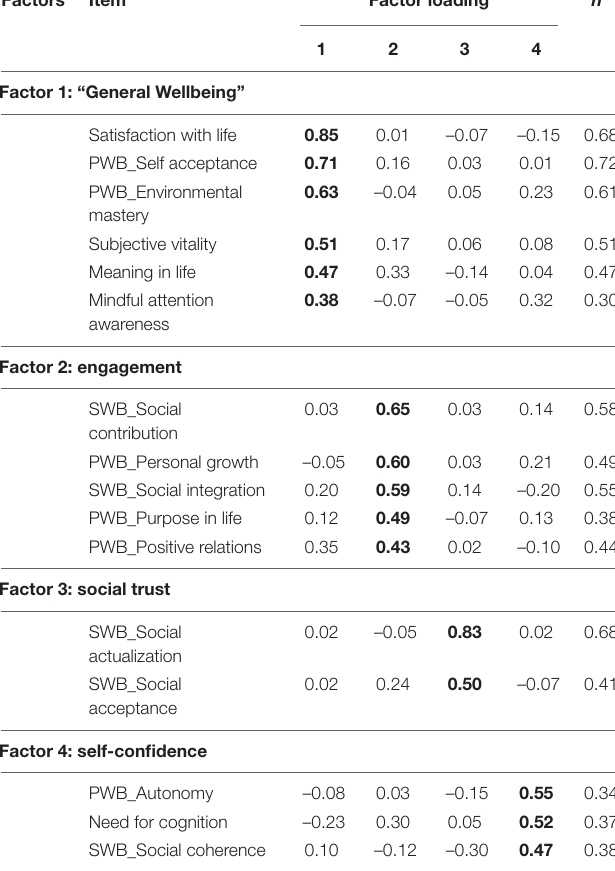
TABLE 3 | Promax rotated factor loadings: EFA 4-factor solution.